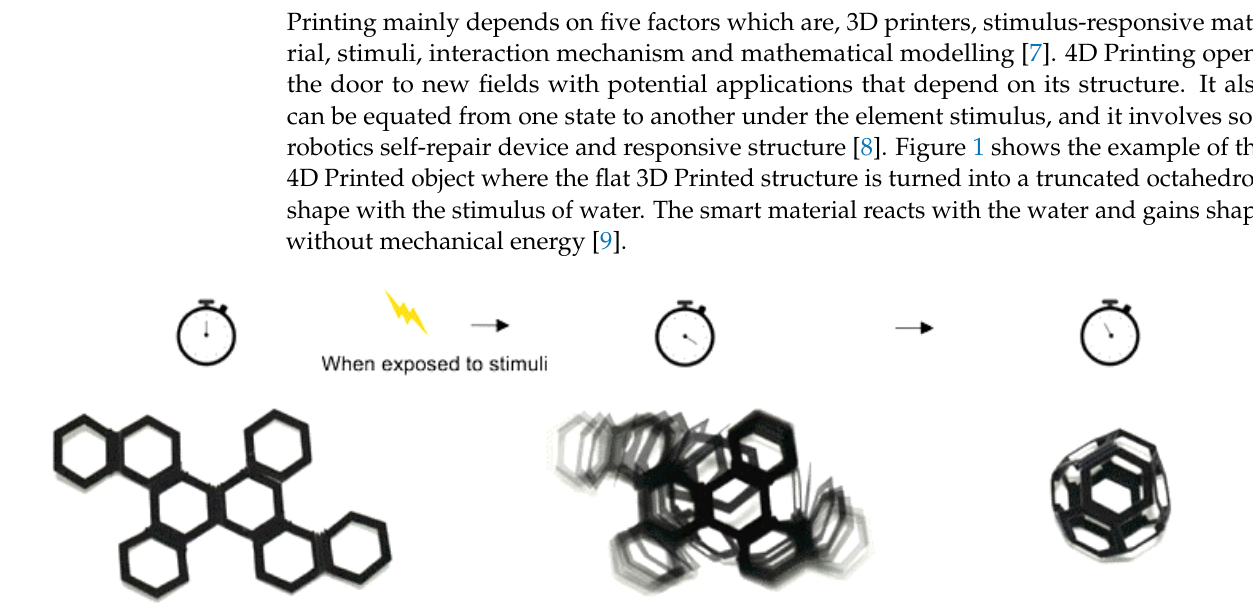
Figure 1. The example of a 4D Printed object that changes shape in water (reproduced from, [9] with permission from Springer International Publishing, 2018).